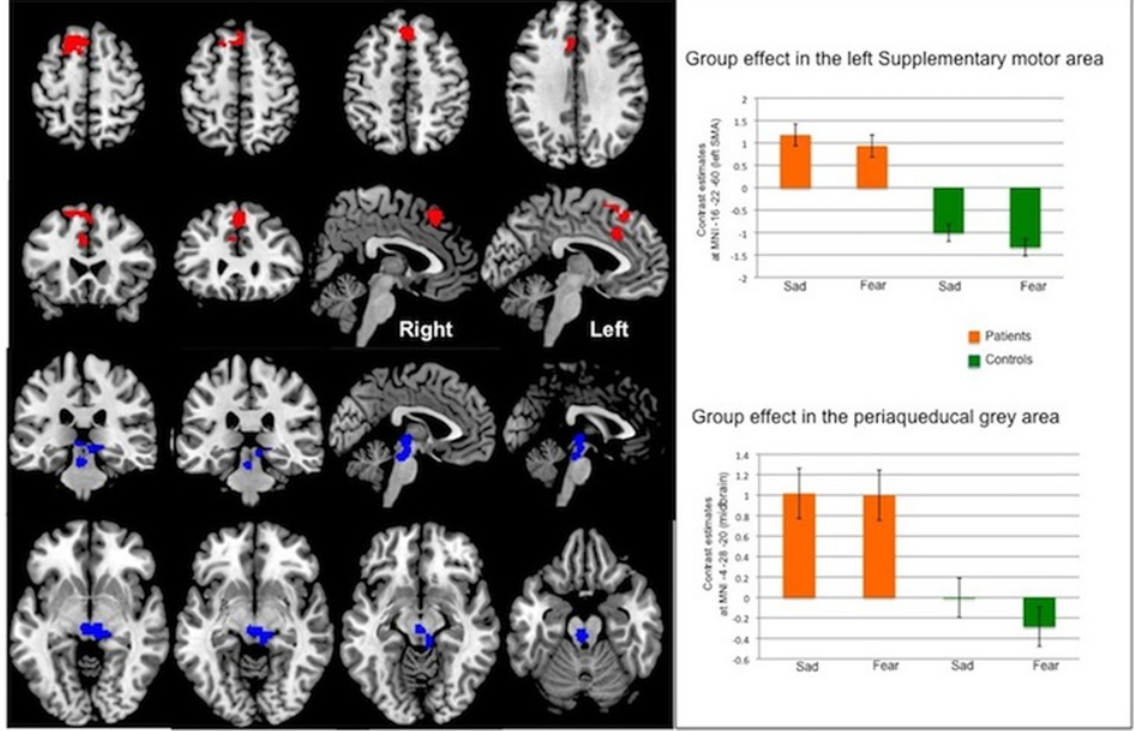
Fig 3. Whole-brain analysis: Group effect in the Emotion Model. Statistical maps have been thresholded at p < 0.001 uncorrected. Upper left panel : Activation in a frontal cluster showing a significant group effect (CD patients > healthy controls). Upper right panel : Plots of beta estimates at MNI [ – 16 22 60] (left supplementary motor area). Lower left panel : Activation in a midbain cluster (including the periaqueducal grey area) showing a significant group effect (CD patients > healthy controls). Lower right panel : Plots of beta estimates at MNI [ – 4 – 28 – 20] (midbrain).